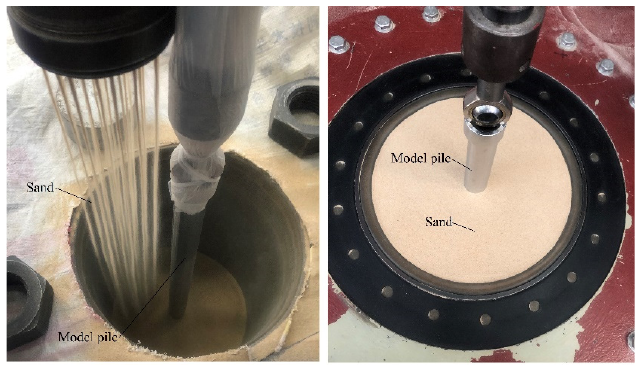
Figure 4. Soil sample preparation.